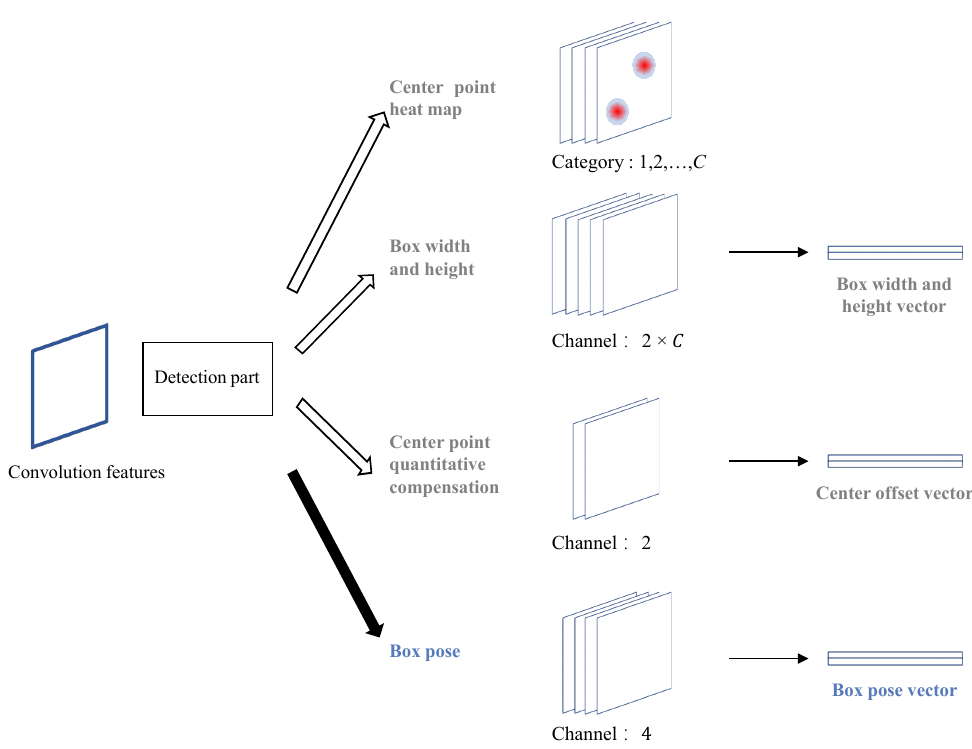
Figure 3. Improved CenterNet detection part. A box pose prediction branch has been added so that it can predict the tilted bounding